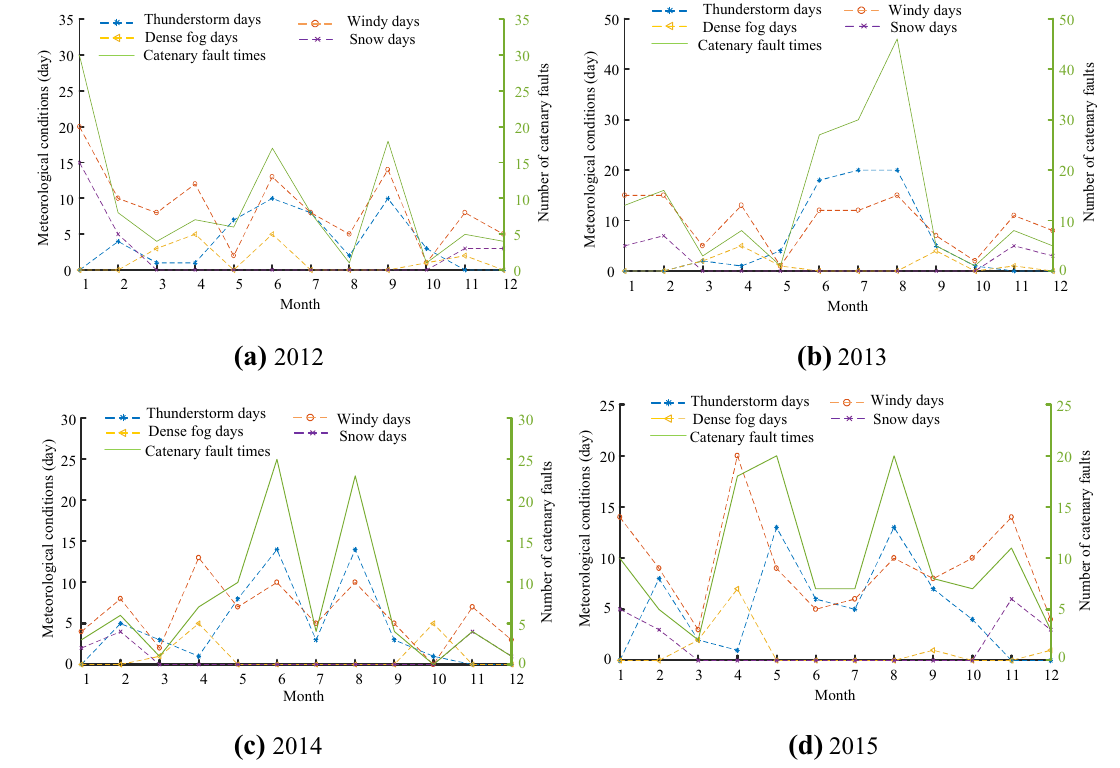
Fig. 1 Number of catenary faults and different meteorological days for 2012–2015